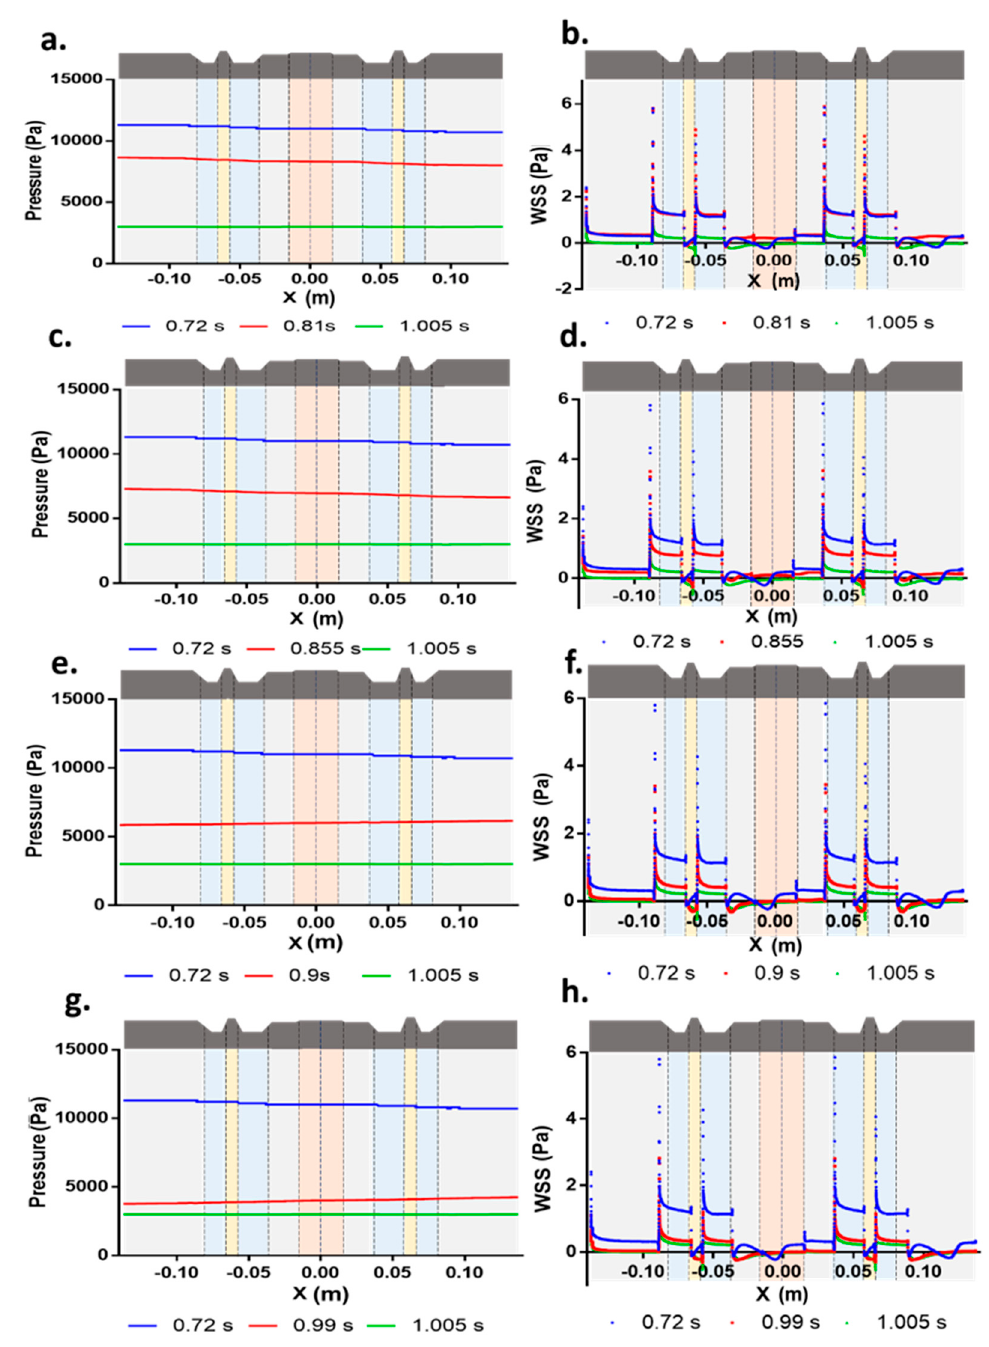
Figure 13. Pressure and Wall Shear Stress distributions along the global geometry of the computational domain for Phase 2. Initial and final time steps for each phase are included as a comparison reference for the chosen time steps on both stages. ( a ) Pressure and ( b ) Wall Shear Stress for t = 0.81. ( c ) Pressure and ( d ) Wall Shear Stress for t = 0.855. ( e ) Pressure and ( f ) Wall Shear Stress for t = 0.9. ( g ) Pressure and ( h ) Wall Shear Stress for t = 0.99.